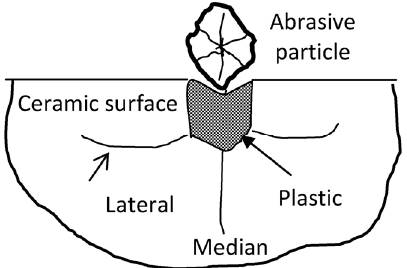
Fig. 2 Crack propagation in a brittle material (e.g., ceramic/ ceramic coating)